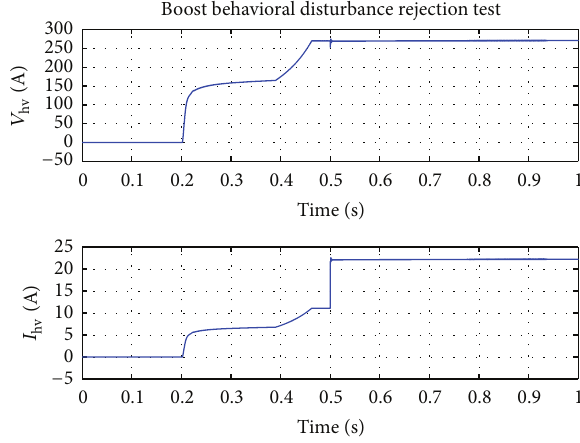
Figure 12: Buck mode test for behavioral robustness test.